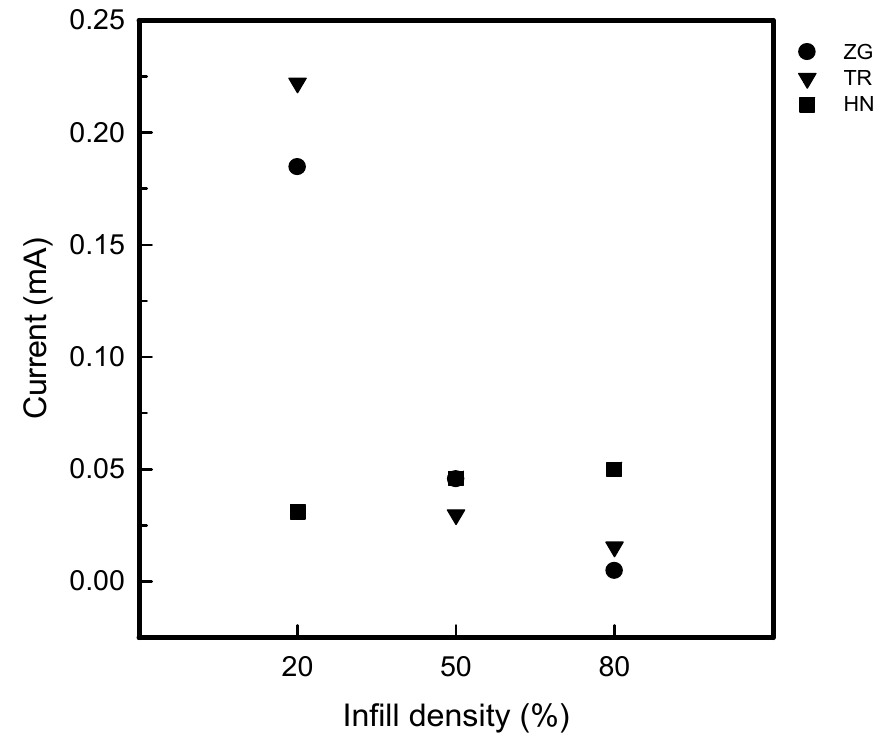
Figure 7. The current at 30V of coated 3DP index fingertips with 8 wt% GR/WPU composite solution under various infill patterns and